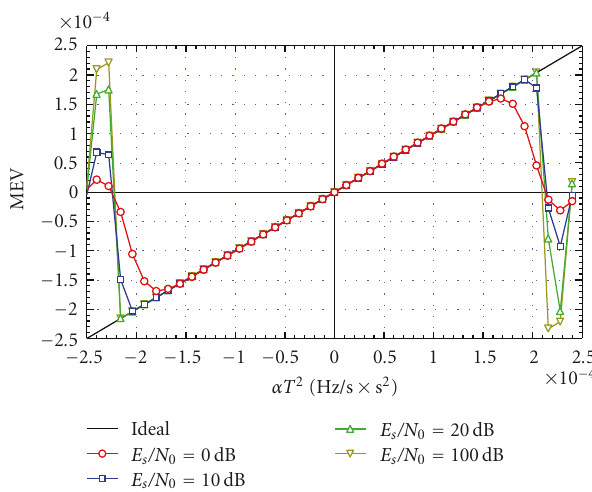
Figure 7: MEV of FREFE estimator for di ff erent values of E S /N 0 — simulation only. Preamble + postamble Luise and Reggiannini, N = 44, M = 385, vT = 1 . 0 × 10 − 3 .